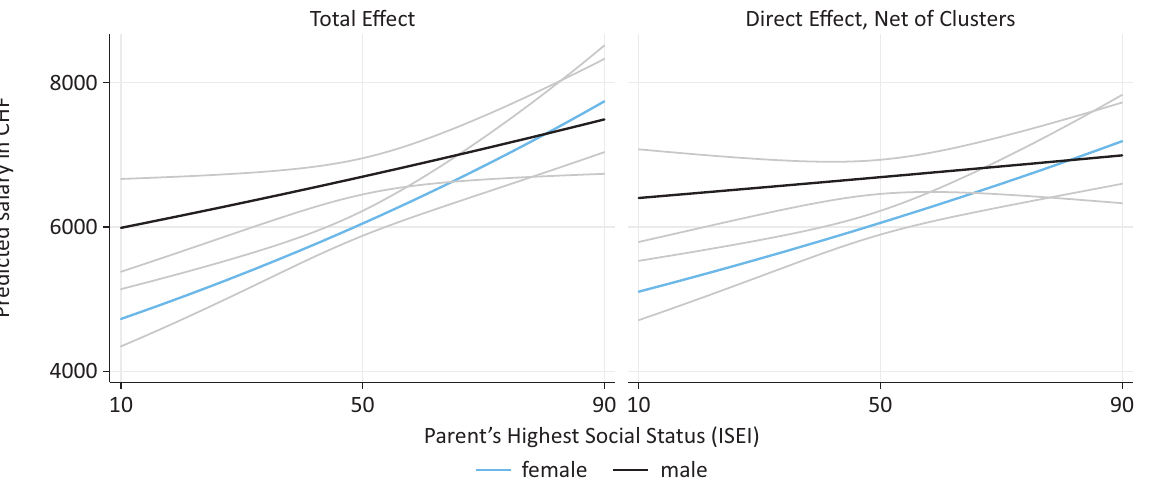
Figure 7. Predictions of salary in 2014 (age ~30), by parental social status (ISEI) and gender; predictions back-transformed from log salary, grey lines: